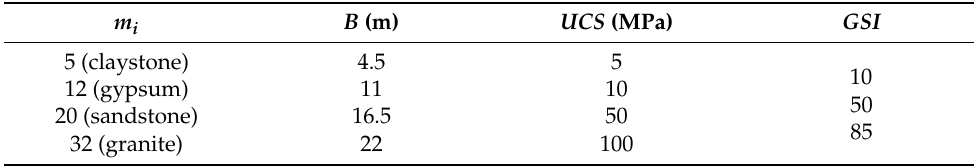
Table 1. Summary of the adopted